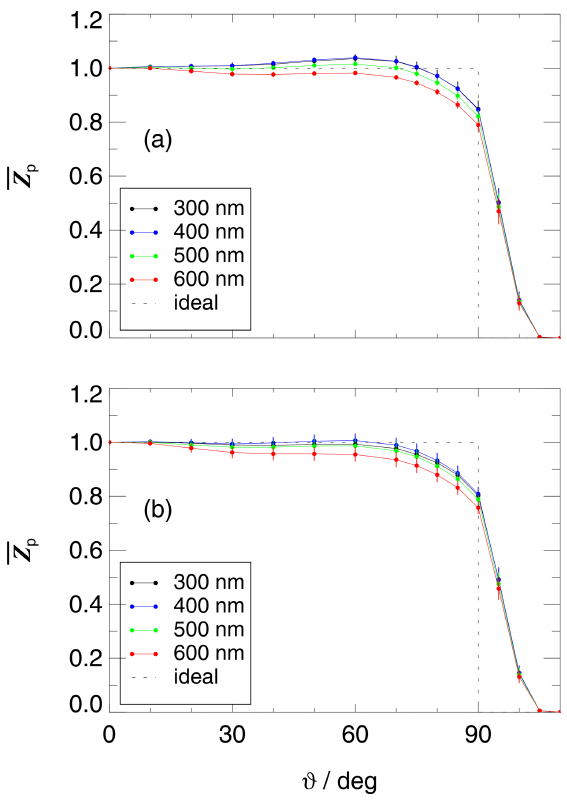
Figure 5. Azimuthal averages of relative angular sensitivities Z p of HALO (a) and (b) receivers for selected wavelengths. Error bars indicate standard deviations of the azimuthal variabilities. The sen- sitivity of an ideal 2 π receiver is shown for comparison (dashed line). The receivers were built into substitutes of aircraft flanges as shown in Fig.